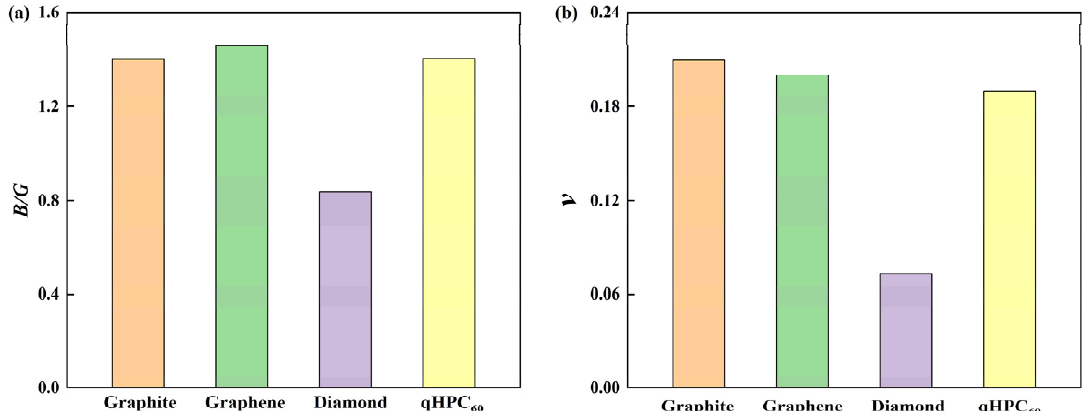
Figure 2. B / G ( a ) and Poisson’s ratio ( b ) for the four carbon materials.